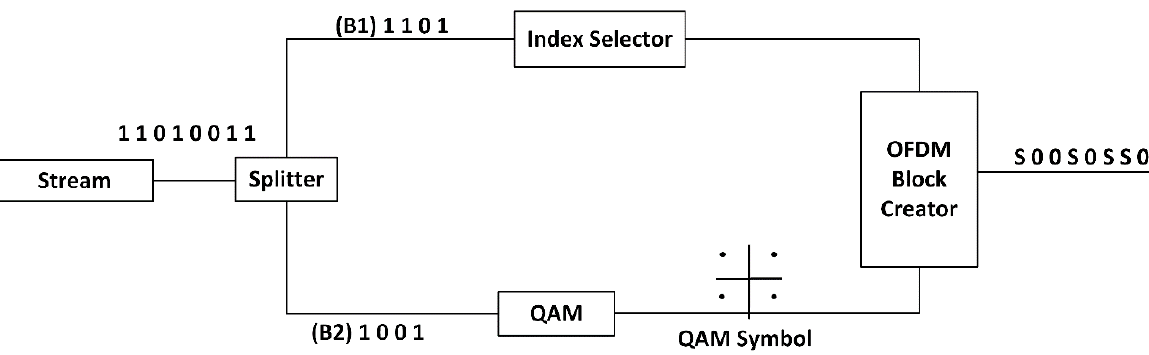
Figure 2. Block diagram of SIM OFDM sub-block creator.